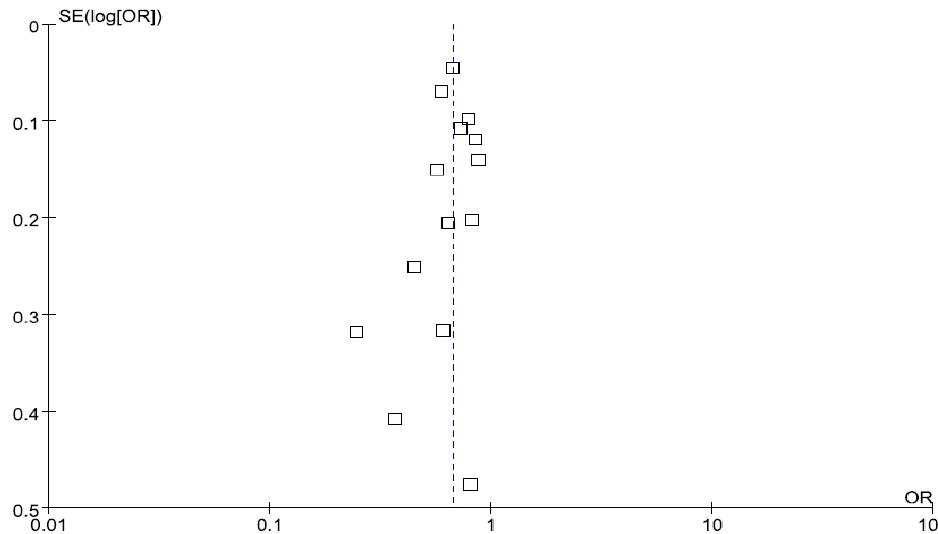
Figure A1. Funnel plots for coronary heart disease(CHD) in the highest compared with the lowest category of intake of the “healthy” dietary pattern in all studies.